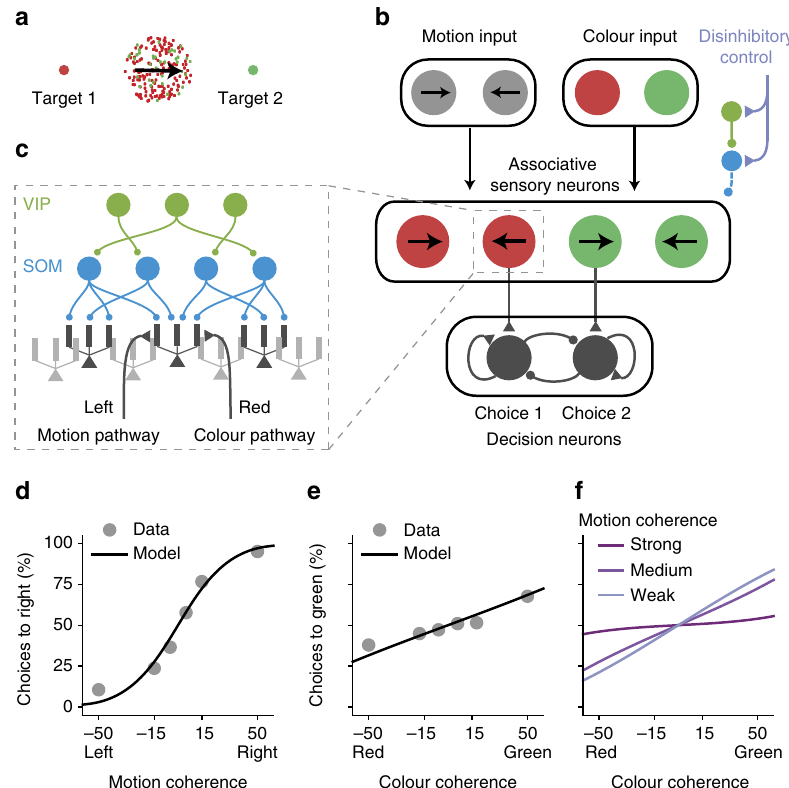
Figure 8 | Pathway-specific gating in an example context-dependent decision-making task. ( a ) A flexible decision-making task. Depending on the context, the subject’s behavioural response should be based on either the colour or the motion direction of the stimulus. ( b ) The circuit model scheme. Motion and colour pathways target associative sensory neurons, which are subject to context-dependent disinhibitory control. Neurons preferring colour and motion evidence for the same target project to the corresponding neural pool in the decision-making circuit. ( c ) Associative sensory neurons receive converging inputs from both motion and colour pathways, and are controlled by the dendrite-targeting interneuronal circuit. ( d – f ) Fit and prediction of behavioural performance. Behavioural performance in the motion context as a function of motion coherence ( d ) and colour coherence ( e ) for a monkey (dots), and the model’s fit (line). Experimental data are extracted from ref. 28. The model can capture the behavioural performance of a monkey. ( f ) In the model, the impact of the irrelevant pathway (colour) is strongest when the relevant pathway signal is weak (with low motion